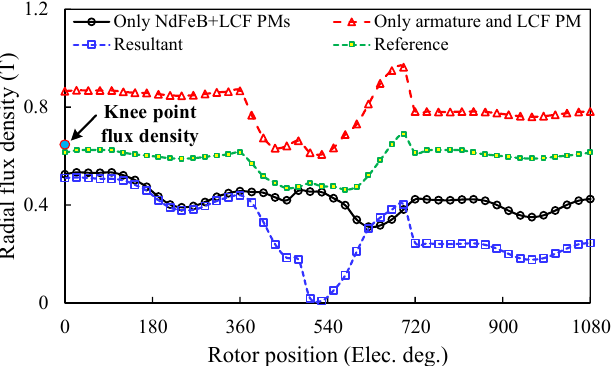
Figure 11. Influences of various excited sources on the working points of the LCF PM under rated load. Table 1. Operating Flux Densities of LCF PMs during Demagnetization.